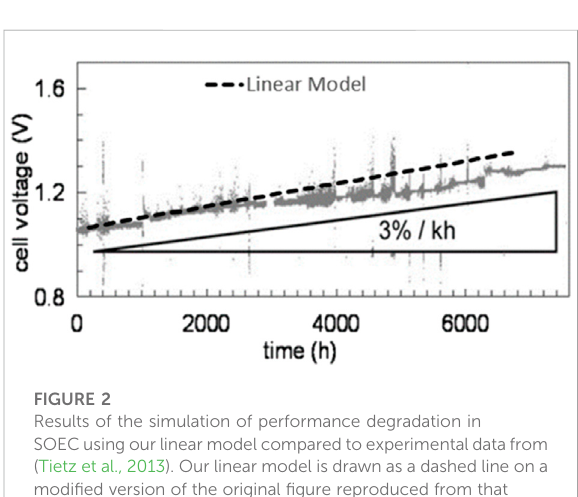
FIGURE 2 Results of the simulation of performance degradation in SOECusing ourlinear model compared to experimentaldatafrom (Tietz et al., 2013). Our linear model is drawn as a dashed line on